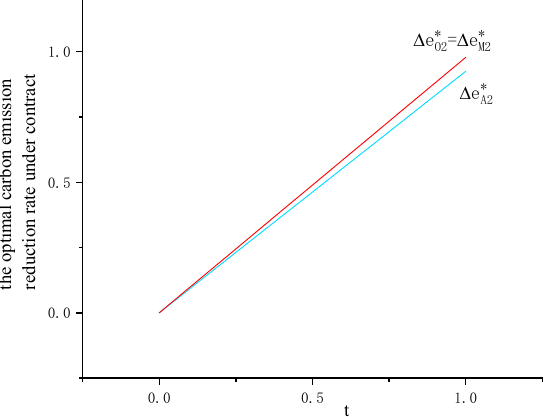
Figure 4. Influence of carbon emission tax on the carbon emission reduction rate under contracts ( r = 0.3, c 0 = 1.5).